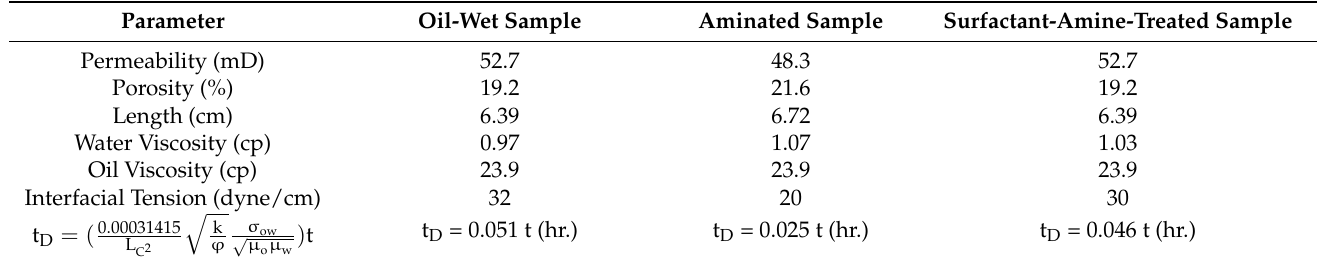
Table 4. The characteristics of the carbonate samples and fluids used in spontaneous imbibition experiments.